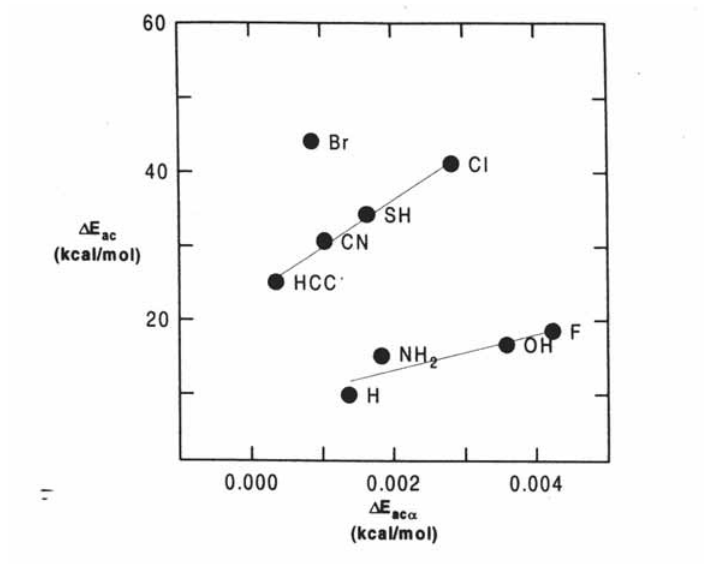
(kcal mol -1 ) as a function of the ac